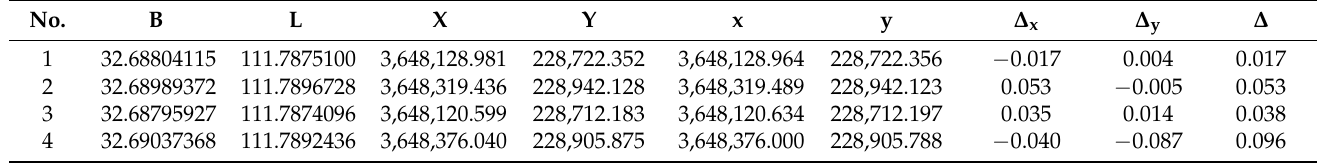
Figure 16. Point error interval distribution. Table 5. Three-dimensional model and model’s detected crack location